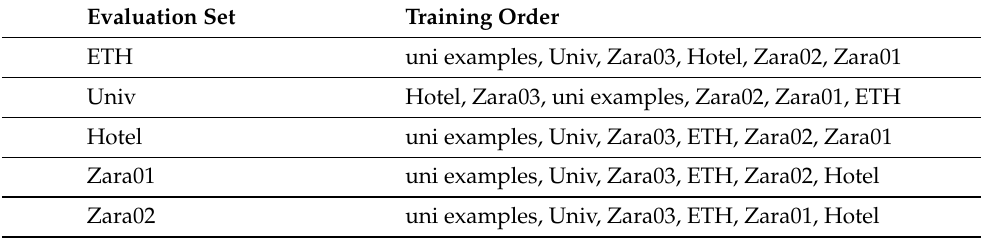
Table 3. Dataset feeding order for the online